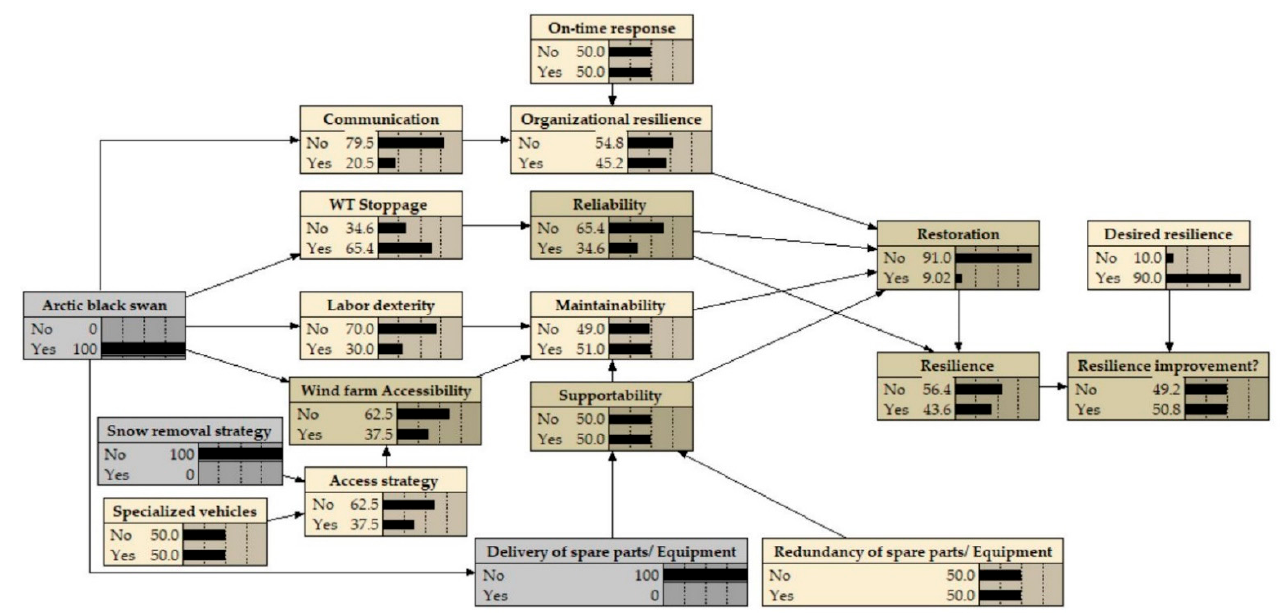
Figure 7. Arctic black swan scenario Bayesian network for resilience calculation.